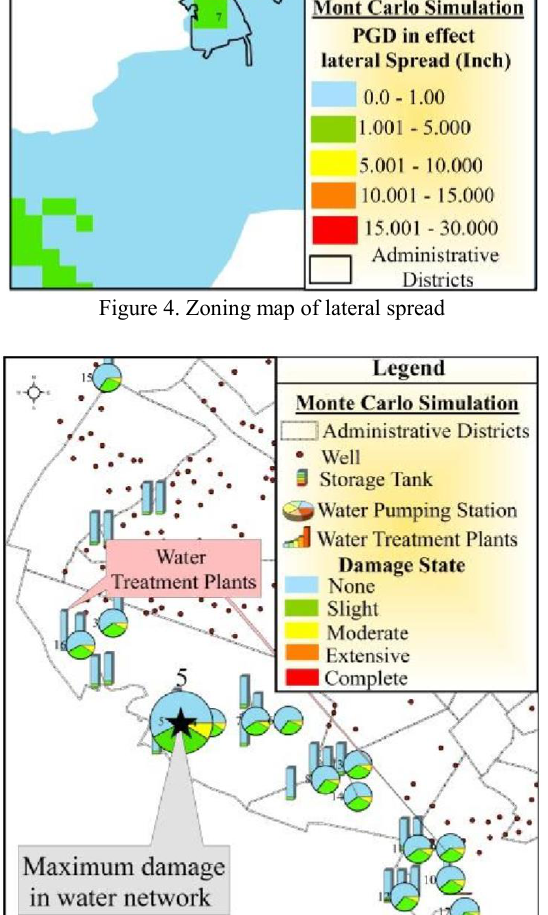
Figure 5. Seismic damage analysis map of the water